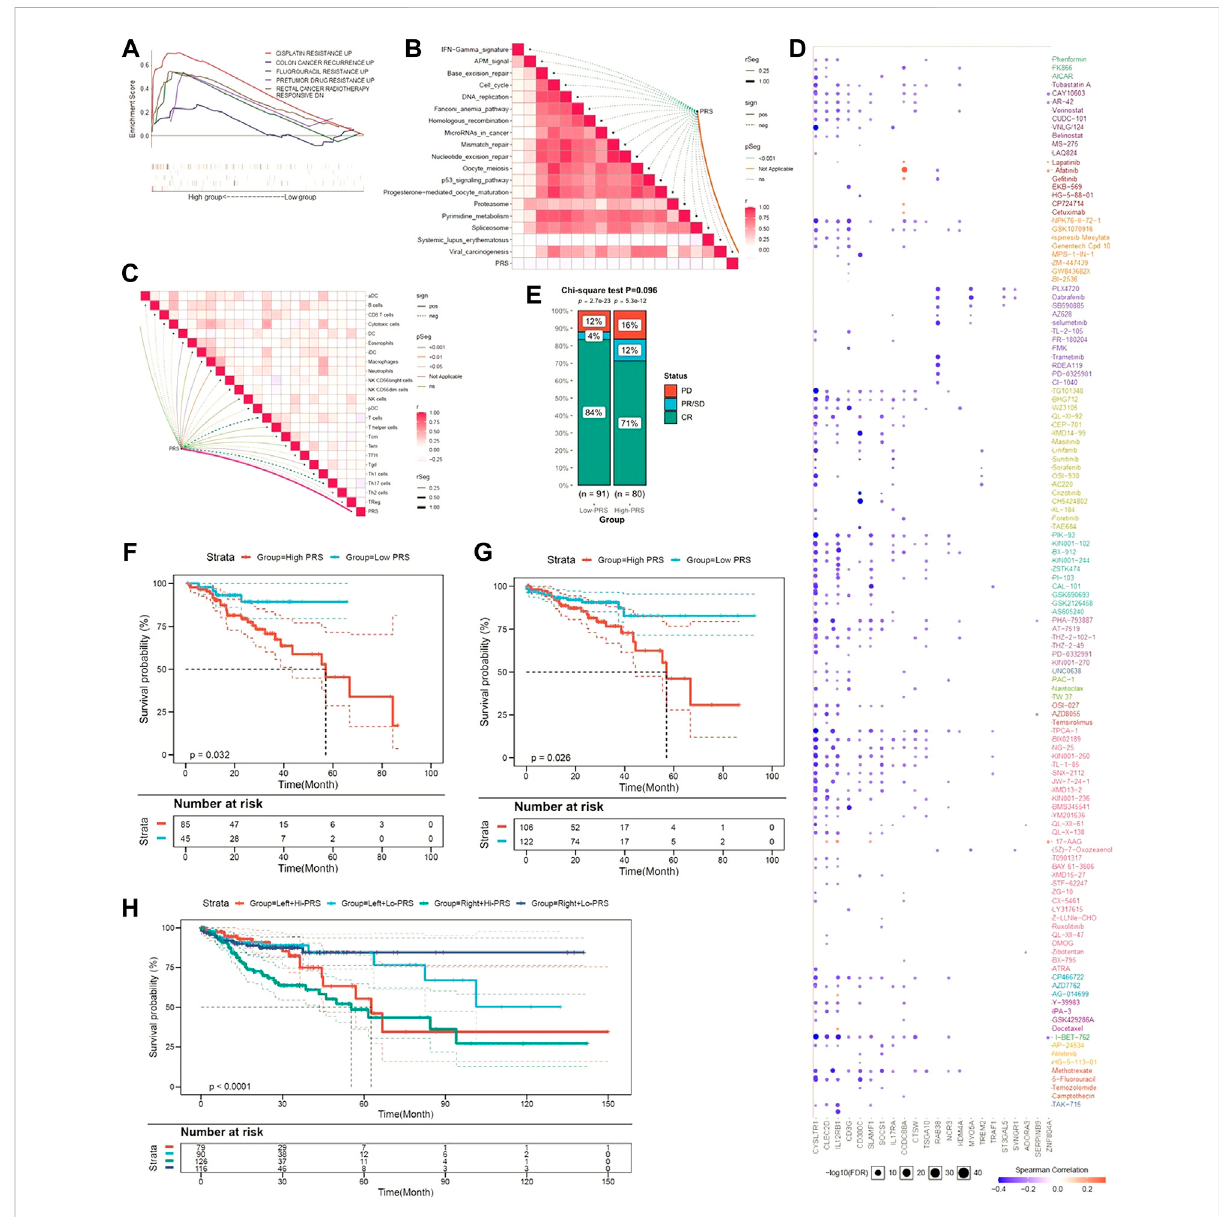
FIGURE 6 The pyroptotic-related gene signature is a promising marker of therapeutic resistance. (A) GSEA con fi rmed that the gene signature was associated with therapeutic resistance. (B) PRS is negatively associated with virous cancer therapeutic pathways. (C) PRS is related to immunosuppressive cells. (D) A landscape plot was conducted to depict the relationships between different molecules and the pyroptosis-related genesignature. (E) TheratioofworseoutcomesaftersurgeryisgreatlyelevatedinhigherPRSgroup. (F – H) Low-PRSisaprognosticmarkerofa more favorable outcome in different subgroups (6F: drugs; 6G: surgery; 6H: location of primary